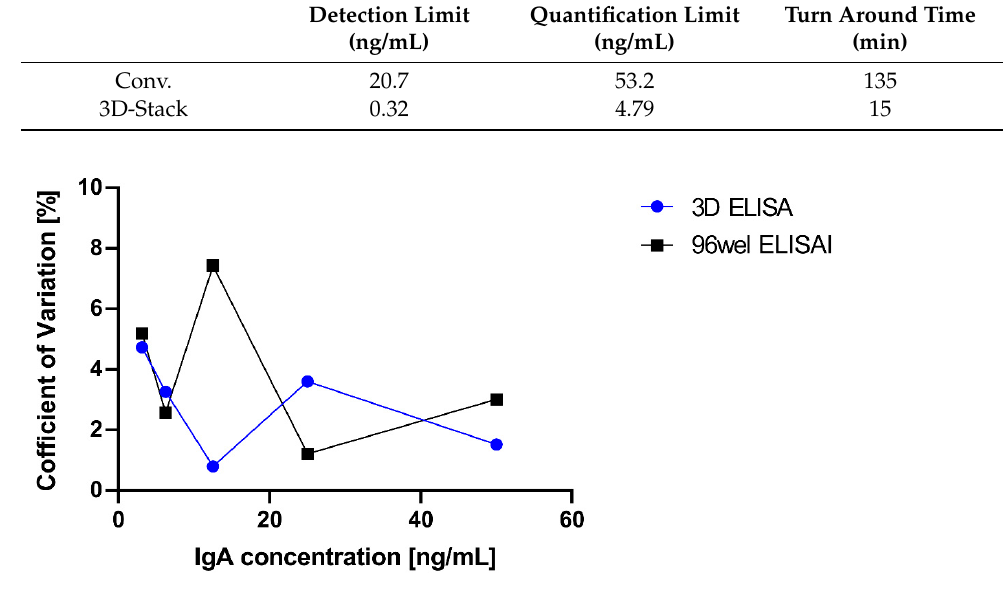
Figure 16. Coefficient of variation in the result of absorbance for each condition of ELISA.